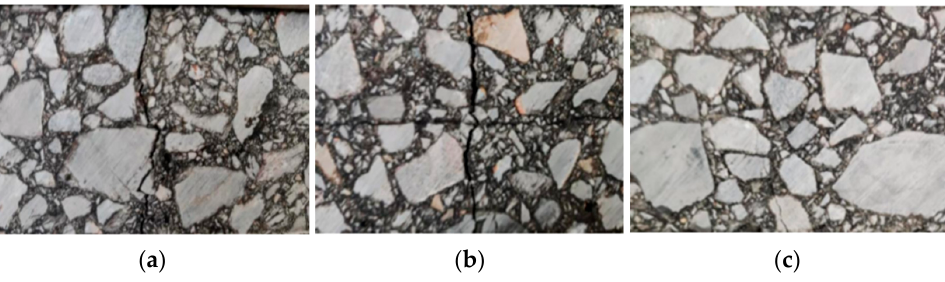
Figure 7. Crack propagation diagram of the AC-20C. ( a ) Unreinforced, ( b ) geotextile, ( c )